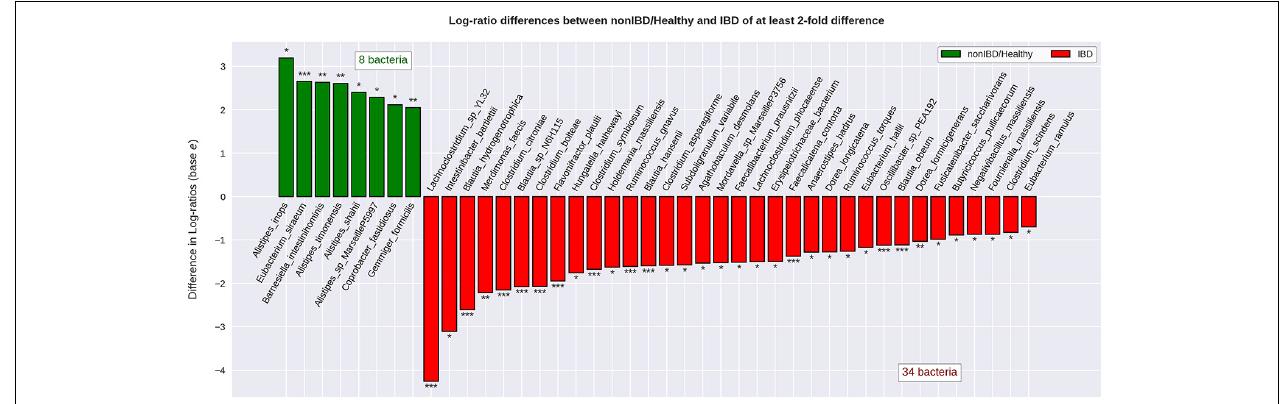
FIGURE 4 | Differential abundance of bacterial species when comparing IBD to non-IBD and healthy groups. Relative abundance values were CLR-transformed and differential abundance was calculated for IBD compared to non-IBD, IBD compared to Healthy-1, and IBD compared to Healthy-2. The species that were significantly differentially abundant in IBD relative to every single other group were considered to be significantly differentially abundant resulting in 42 significantly differentially abundant bacterial species. Of these 42 species, 34 were found to be significantly more abundant in IBD relative to every other group and 8 bacterial species were found to be significantly less abundant in IBD, relative to every other group. The transformed relative abundances were then averaged and displayed under one label (non-IBD/Healthy) for ease of visualization. * Indicates a q -value < 0.05. ** Indicates a q -value < 0.01. *** Indicates a q -value <